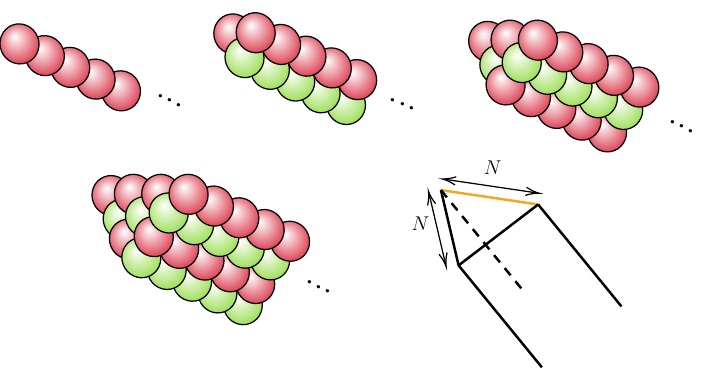
Figure 9 . The crystal for chamber e C N for C × C 2 / Z 2 . Here we show the cases for N = 1 , 2 , 3 , 4 . We also give a sketch of general N with the orange line as the top row. The crystal is infinitely